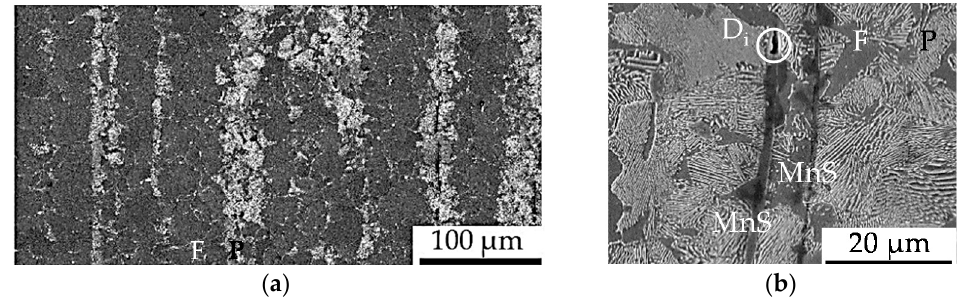
Figure 3. ( a ) Ferrite (F)–pearlite (P) microstructure after etching with Nital 3%; ( b ) forming-induced initial damage (D i ) at the tip of a manganese sulfide (MnS)-inclusions in pre-dominantly pearlite (P) grains interrupted by ferrite grains (F).